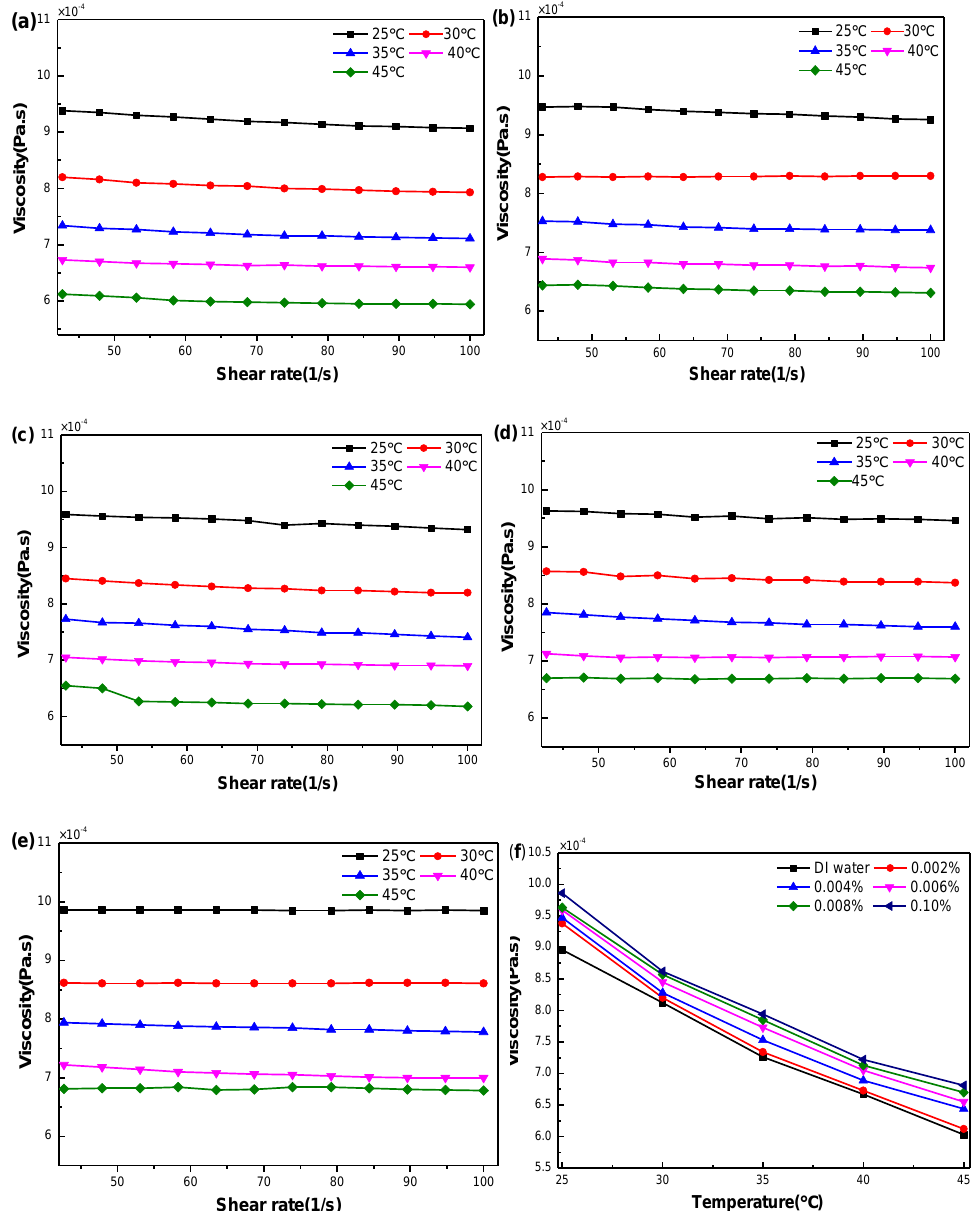
Figure 4. Relationship between viscosity and shear rate of nanofluids ( a – e ) GO–water 0.002%, 0.004% 0.006%, 0.008% and 0.010% and ( f ) relationship between temperature and dynamic viscosity.